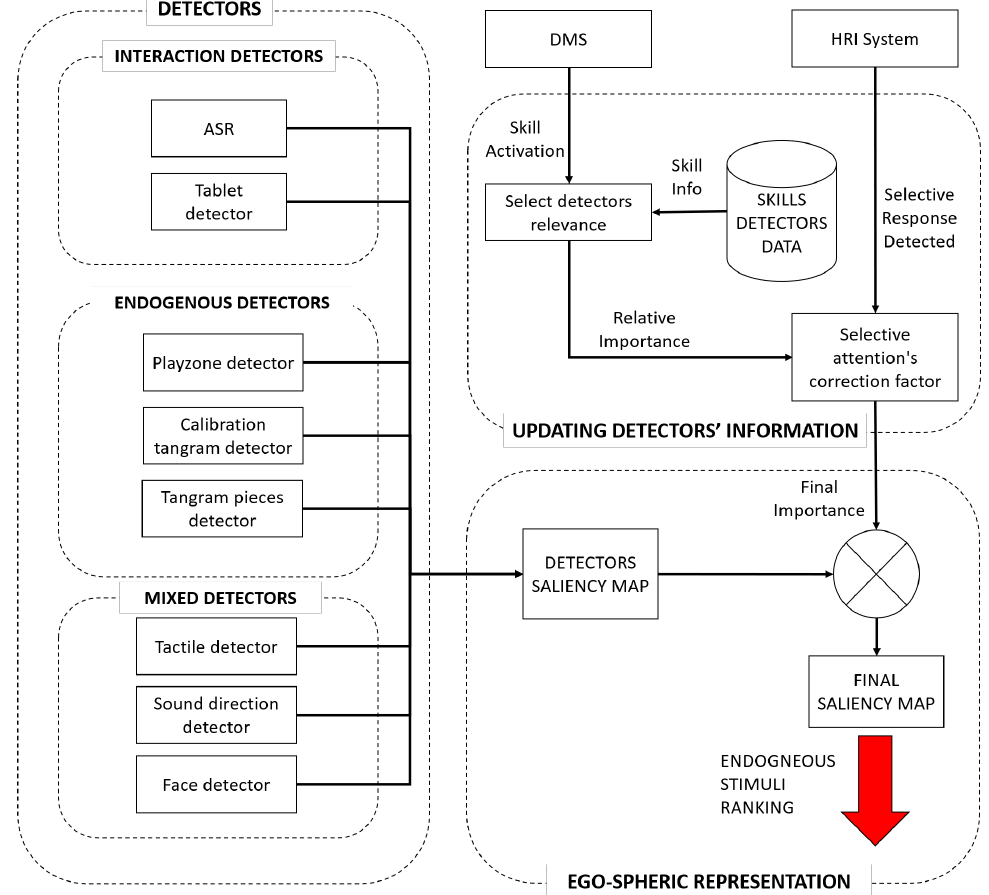
Figure 3. A schematic diagram of the endogenous attention